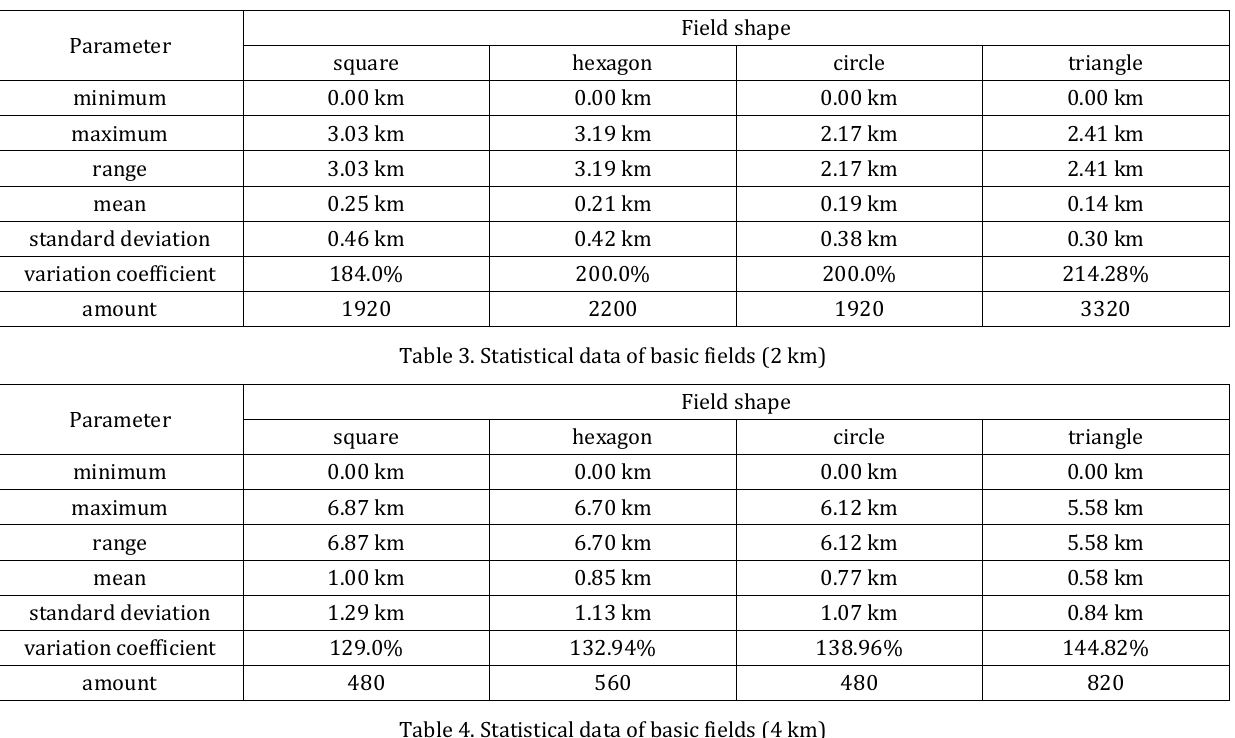
Table 2. Statistical data of basic fields (1 km)